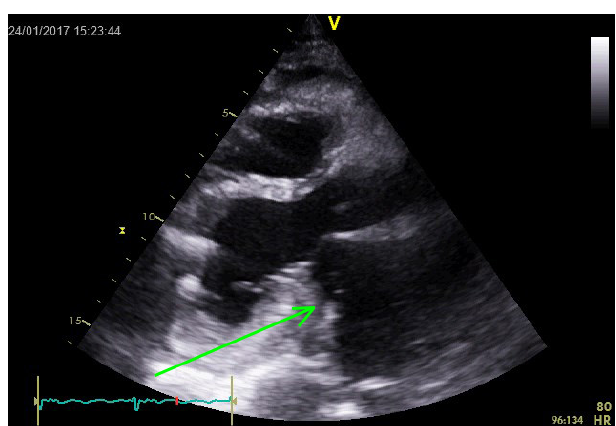
Fig.2 - Follow-up echocardiogram showing residual thickening of the left atrial